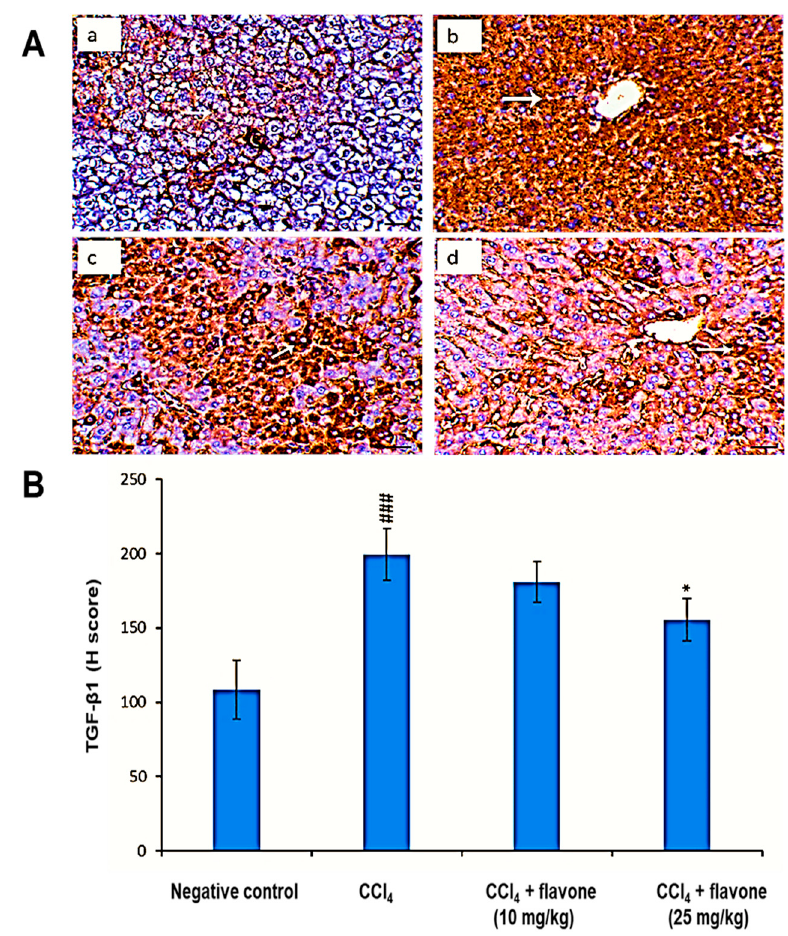
Figure 7. Effect of treatment with the flavone on the TGF- β 1 protein level in liver tissues. A : Representative liver immunohistochemical graphs (a: negative control group, b: carbon tetrachloride (CCl 4 ) group, c: CCl 4 + flavone (10 mg/kg) group, d: CCl 4 + flavone (25 mg/kg) group); ( a ) showed a noticeable expression of TGF- β 1 immunostaining in the liver tissues (arrow). ( b ) presented marked increase in TGF- β 1expression within the liver tissues (arrow). ( c ) displayed mild to moderate decrease of TGF- β 1 expression in the liver tissues (arrow). ( d ) illustrated an obvious decrease in TGF- β 1 expression within the liver tissues (arrow). Scale bar = 100 µm. B : Statistical analysis of TGF- β 1 H-score. Data are expressed as mean ± SD. Significantly ( ### p < 0.001) different to negative control group. Significantly (* p < 0.05) different to the CCl 4 group.